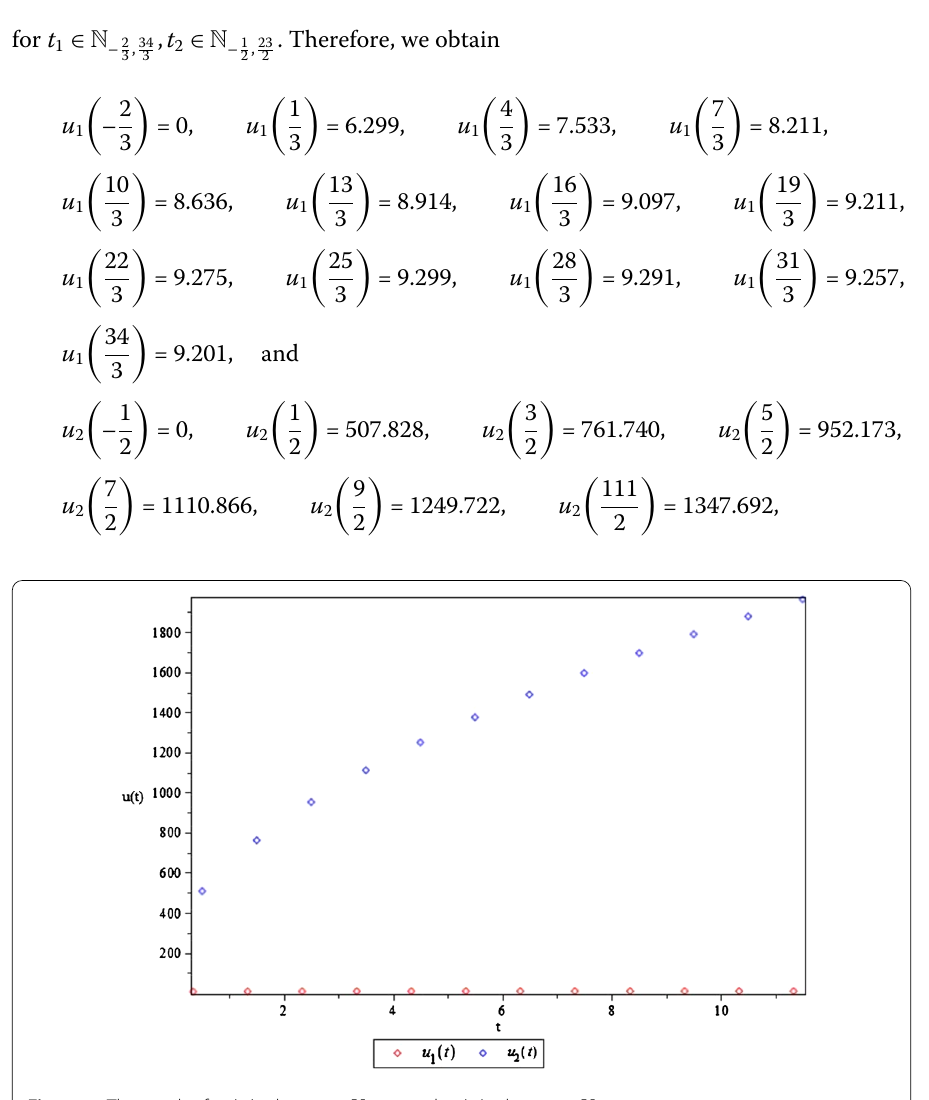
Figure 1 The graph of u 1 ( t 1 ) where t 1 ∈ N 1 3,34